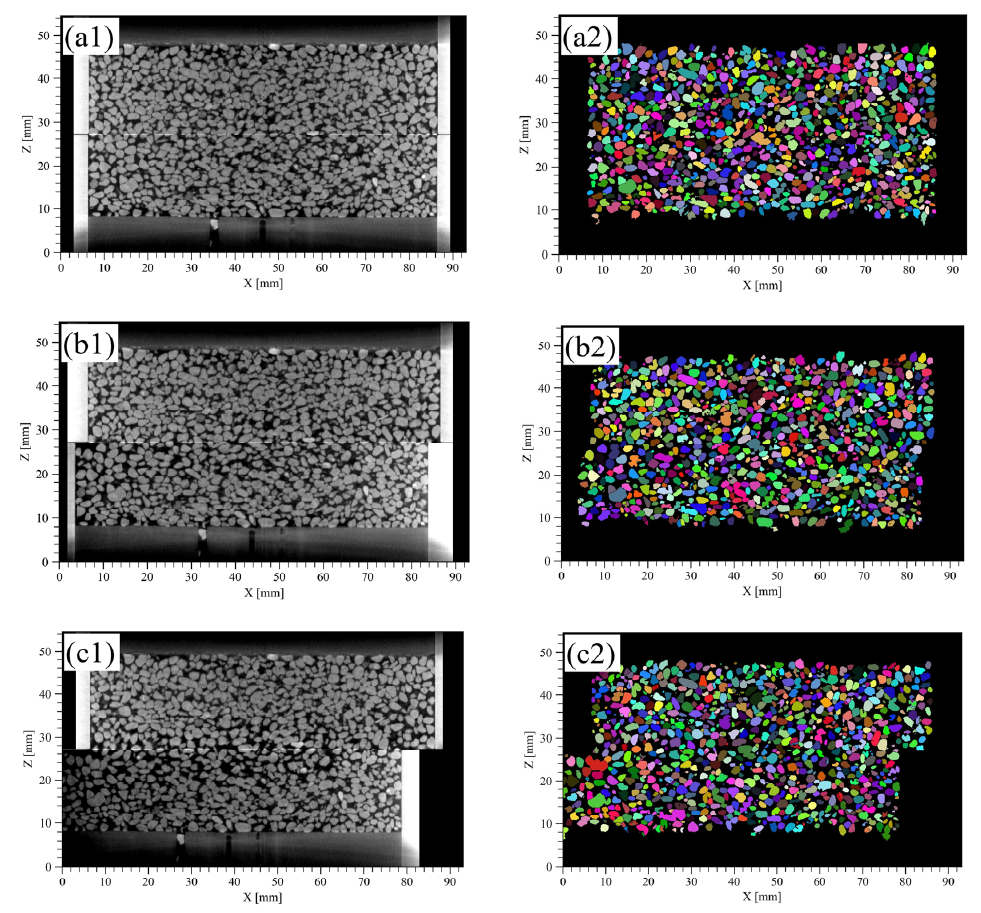
Figure 8. CT images and segmented images of the direct shear experiment on the vertical plane (XZ plane). ( a1 , a2 ) are the results at S0 (initial sate). ( b1 , b2 ) are the results at S2 (D h = 3.0 mm). ( c1 , c2 ) are the results at S4 (D h = 8.0 mm). D h , horizontal displacement. The left columns are CT images, and the right columns are segmented images. The boundary surface between the upper and lower boxes is at a position where the Z-axis is about 27 mm. The lower box is displaced horizontally from the +X to the − X direction.